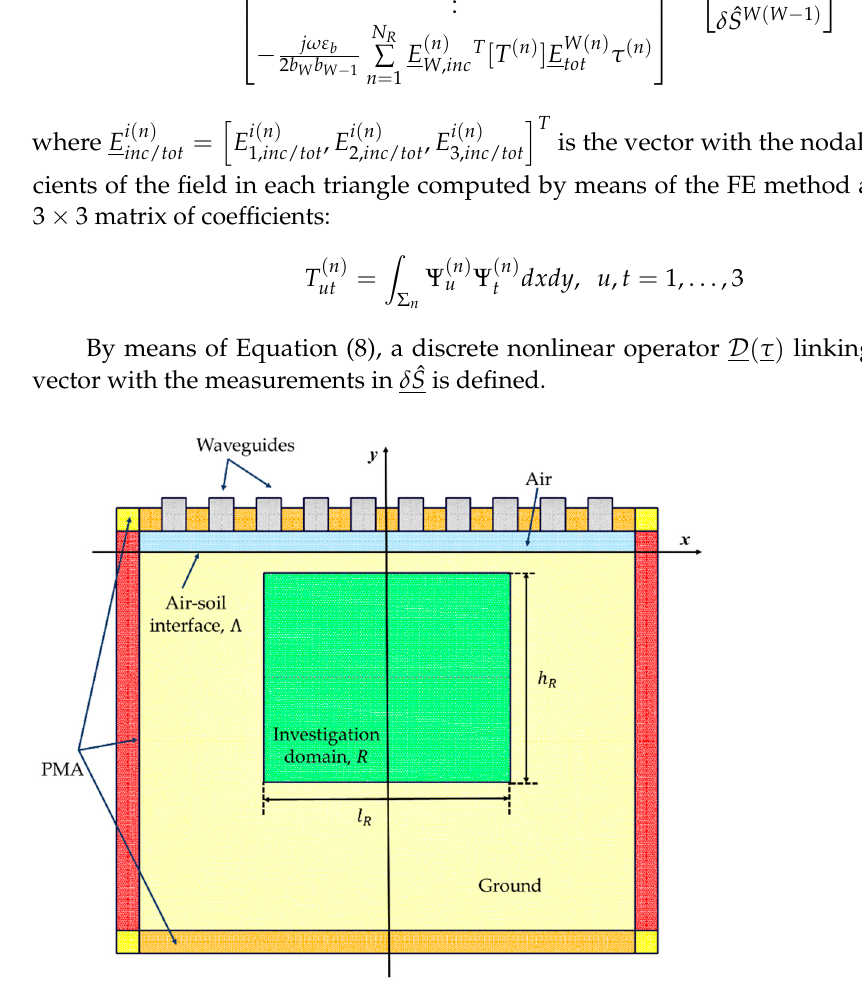
Figure 3. Sketch of simulation and investigation domains.